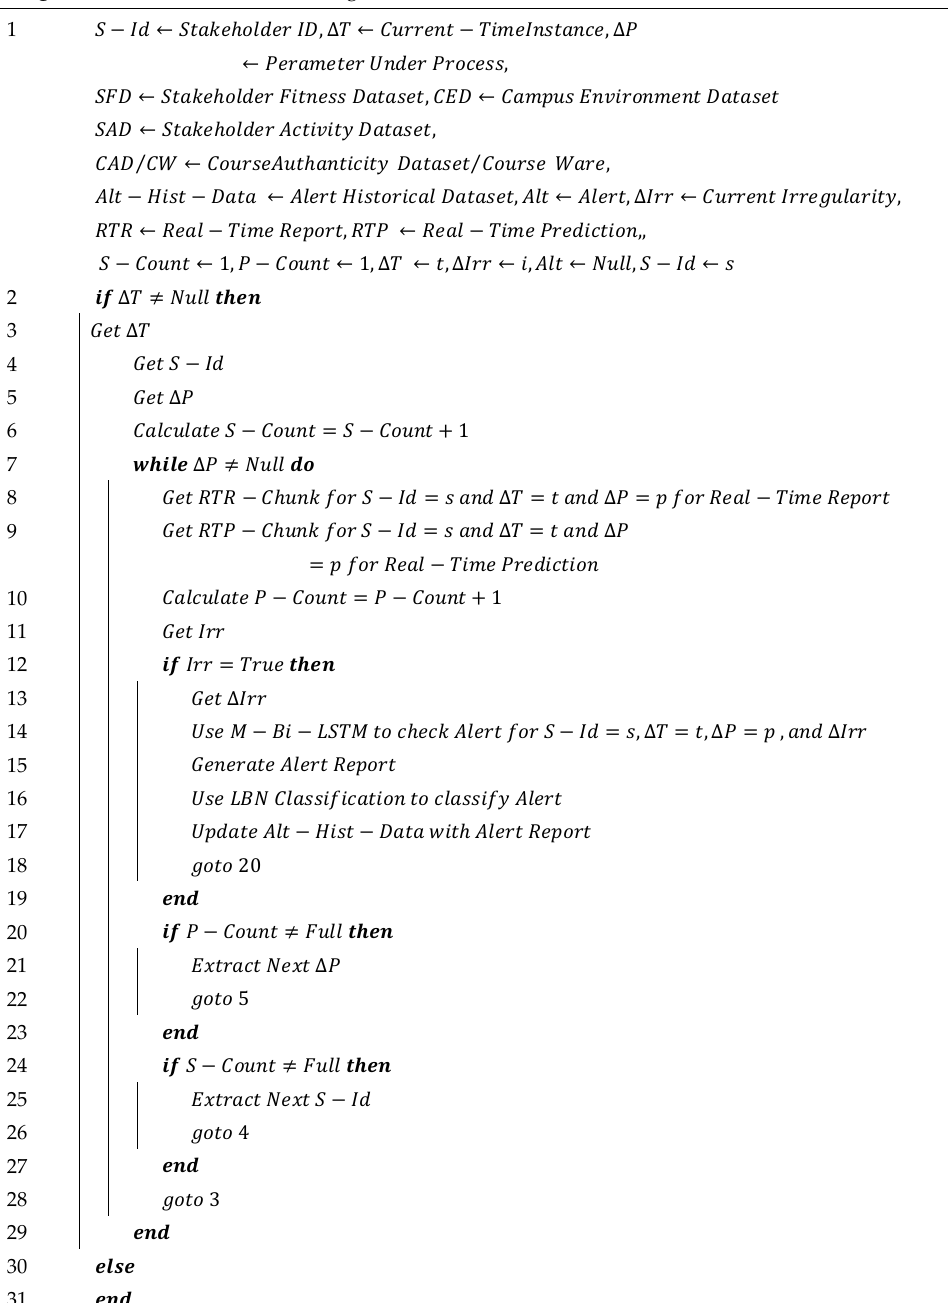
Algorithm 3: Alert Generation Algorithm Algorithm 3 : Alert Generation